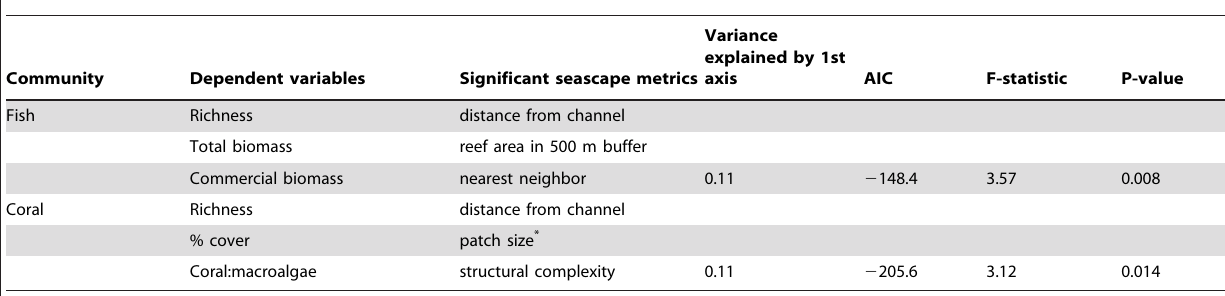
Table 2. Summary of best fit model from CCA